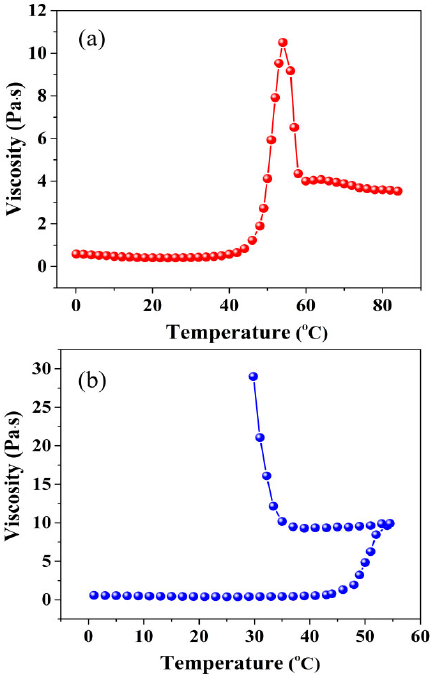
Fig. 3 Viscosity property of alumina slurry with 0.4 wt% carrageenan thermally-induced: (a) on heating and (b) on heating and then on cooling (solid loading was 50